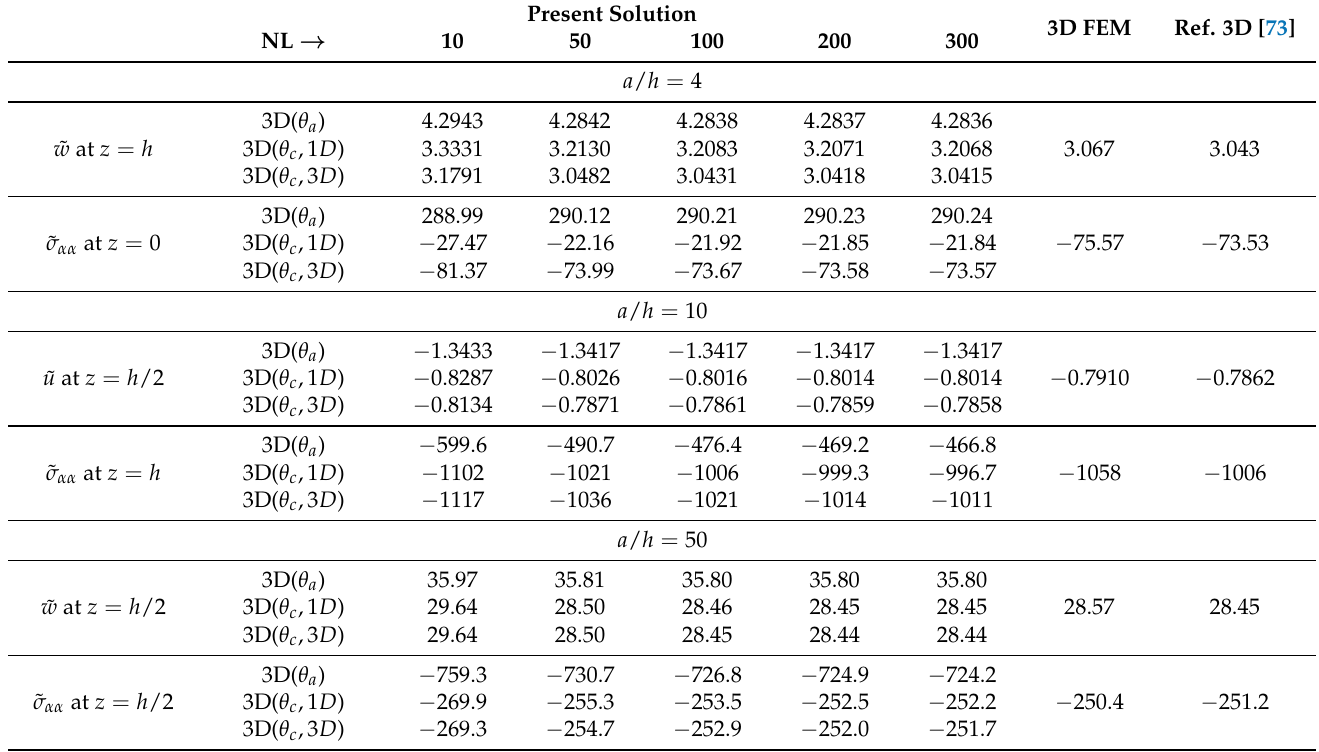
Table 1. First assessment. One-layered FGM square plate ( a / b = 1), featuring different thickness ra- tios. The volume fraction power law considers p = 2 as the exponent. An external sovra-temperature field acts on the top ( θ t = + 1 K) and bottom ( θ b = 0 K) surfaces; m = n = 1. The reference solution is the asymptotic method of Reddy and Cheng [73], considering a 3D temperature profile along with thickness direction. A 3D FE model is also assessed. The results of the present solution are obtained with N = 3 and for a varying number of mathematical layers NL. Present Solution 3D FEM Ref. 3D [73] NL →